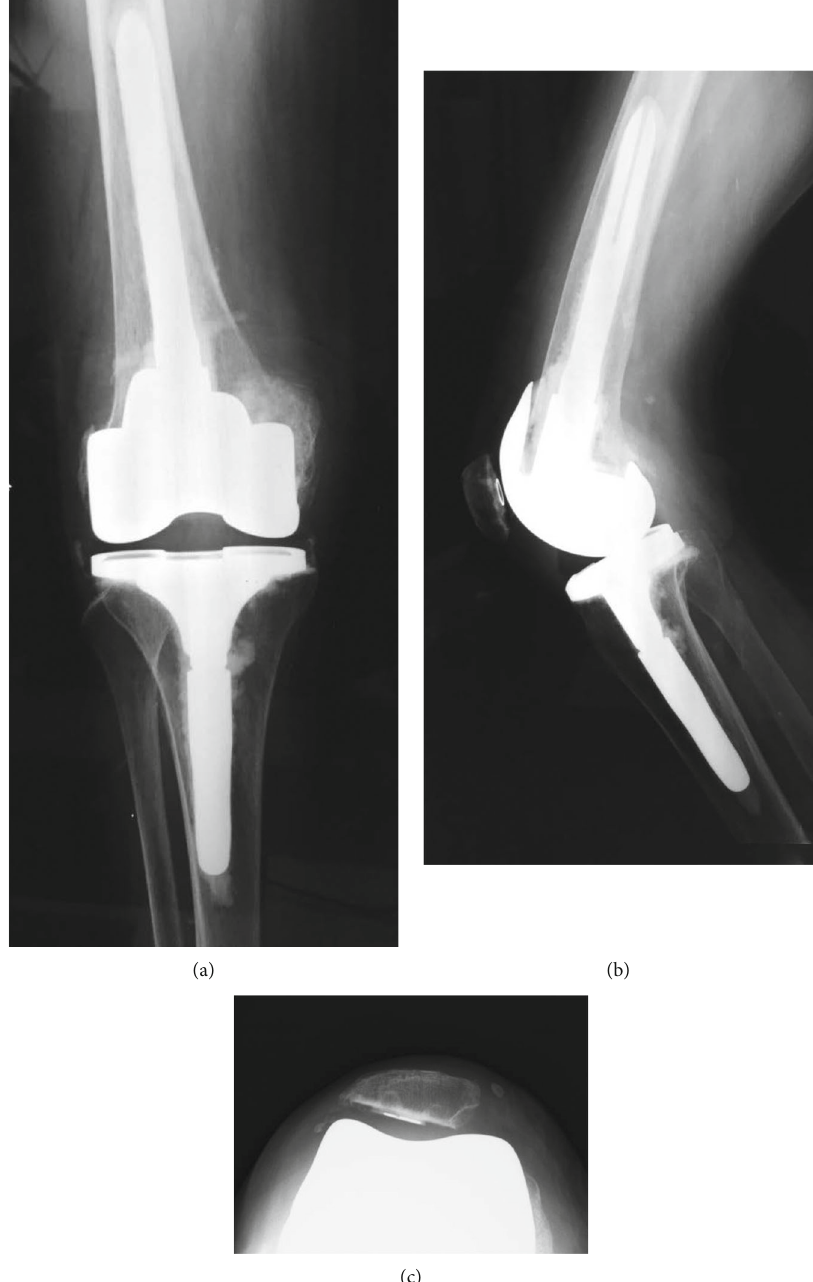
Figure 6: Postoperative radiographs showing total knee arthroplasty using the semiconstrained lesion prosthesis (Smith & Nephew). (a) AP view, (b) lateral view, and (c) axial